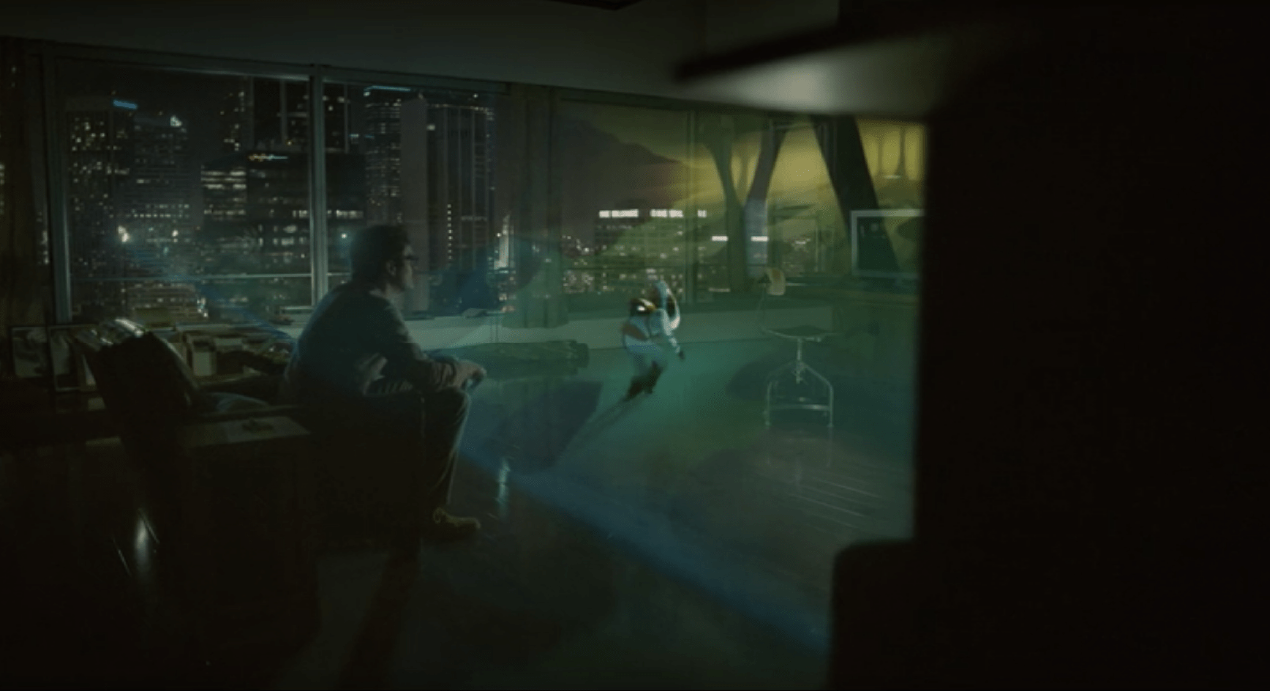
Figure 3. Theo plays Alien Child . (Screenshot created by author).